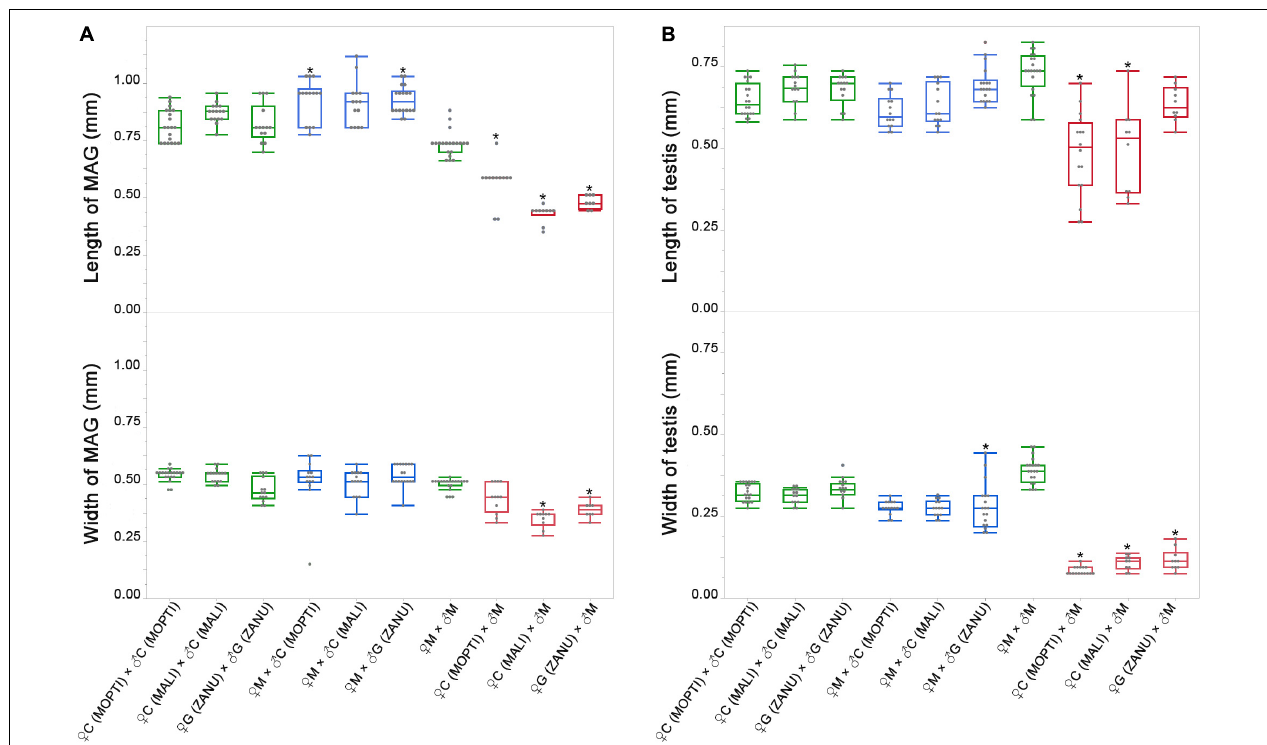
FIGURE 3 | Widths and lengths of the male accessary glands (MAGs) and testes in pure species and in inter-species crosses. (A) Widths and lengths of MAGs in pure species and in inter-species crosses. (B) Widths and lengths of testes in pure species and in inter-species crosses. Green box plots represent measurements in pure species and blue and red box plots represent measurements in F1 hybrids. The lengths and widths of MAGs and testes are shown on the Y axes in mm. M, An. merus ; C, An. coluzzii ; G, An. gambiae. Names of the An. coluzzii and An. gambiae strains are in parentheses with capital letters. The Tukey’s HSD test was used to calculate P -values for comparison of the measurements between hybrids and pure species. * P < 0.0051, the P -value by Sidak